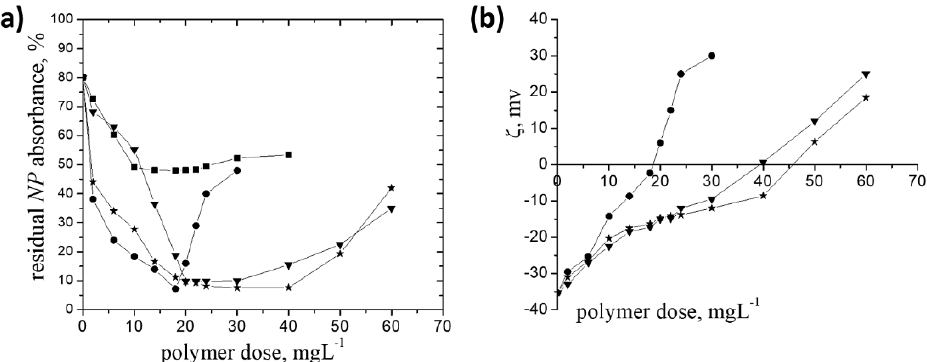
Figure 6. The residual NP absorbance (%) ( a ) and zeta potyential ( ζ ) ( b ) dependence on the polycation dose: P ₋ g ₋ pAPTAC1 (inverted triangle), P ₋ g ₋ pAPTAC2 (star), P ₋ g ₋ pAPTAC3 (circle); 0.1M NaCl P ₋ g ₋ pAPTAC3 (square); c NP (%, w/w ) - 0.7; settling time 120 min.